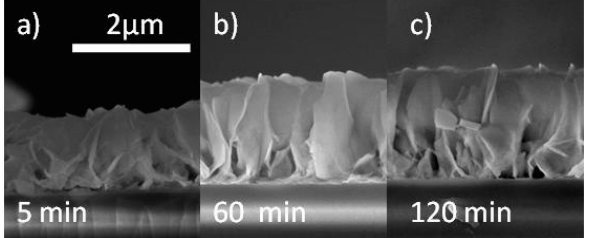
Figure 2. Cross section SEM images of ZnO nanowalls grown for 5 ( a ), 60 ( b ), and 120 ( c ) minutes.